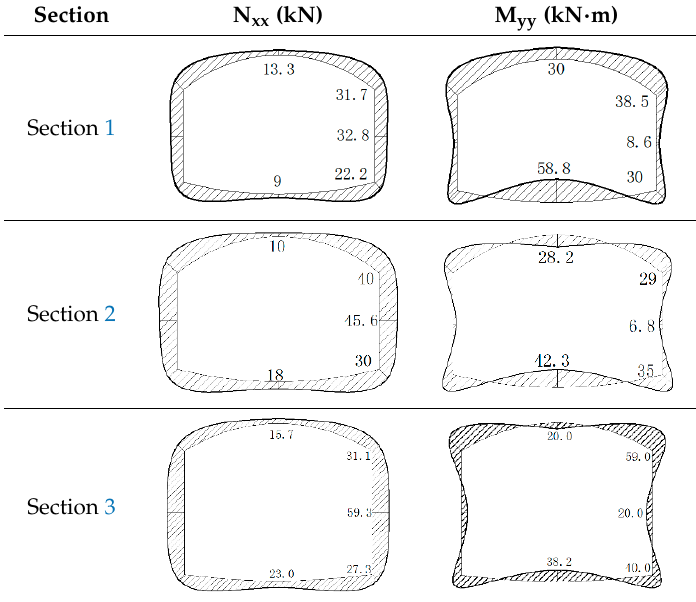
Table 5. Internal force distribution of lining structure.